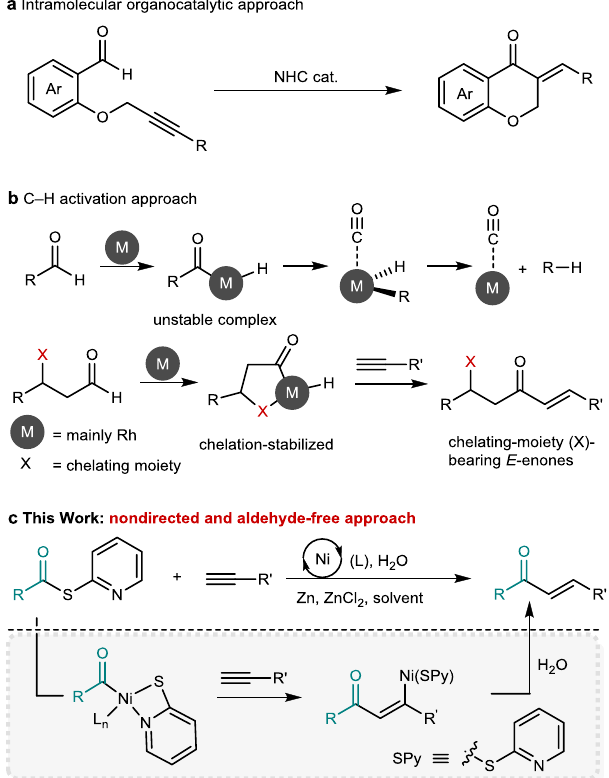
Fig. 1 Hydroacylation of alkynes. Previous works: aldehyde-alkyne coupling, a Intramolecular organocatalytic approach and b C – H activation approach. c ) This work: nondirected and aldehyde-free